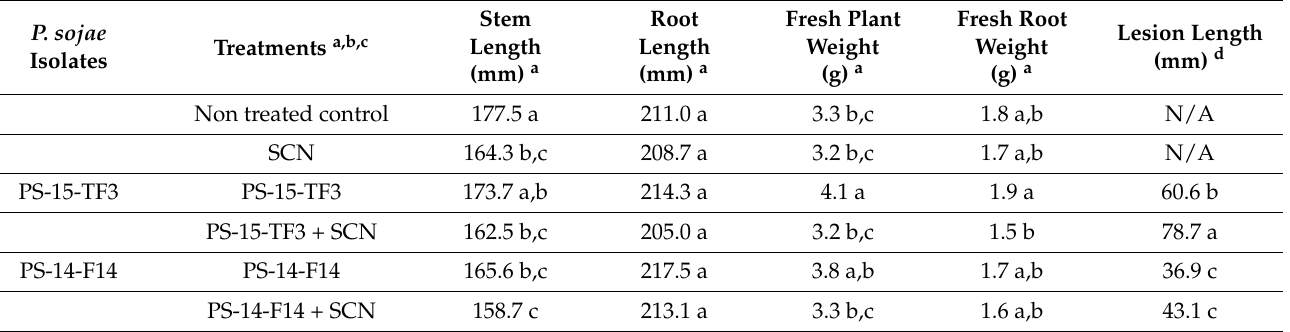
Table 2. Shoot, root length and weight, lesion length measurements observed on the soybean cv. Jack inoculated with SCN or concomitant inoculations of SCN with either of the P. sojae isolates (PS-15-TF3 and